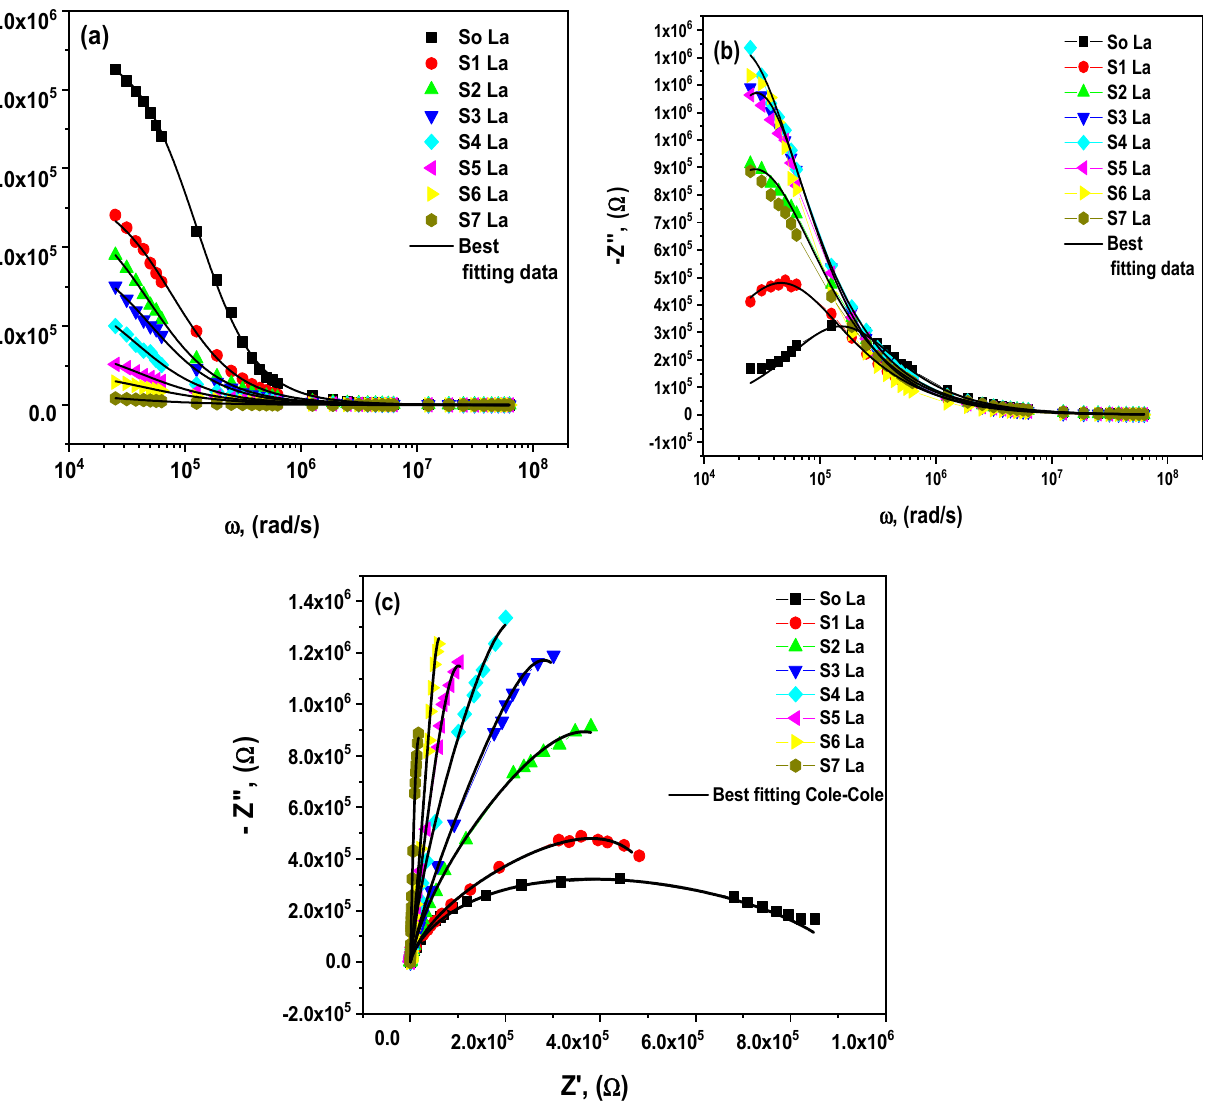
Figure 7. ( a – c ): ( a ) real, ( b ) imaginary parts, and ( c ) Cole-Cole plots (the line represents the theoretical best Cole-Cole fitting) as-prepared La 2 O 3 -ZnO nanostructures. The angular frequency dependence of −𝑍 (cid:4593)(cid:4593) (𝜔) is shown in Figure 7b. The experi- mental results from Figure 8b closely match the theoretical data from Equation (18). Each of the −𝑍 (cid:4593)(cid:4593) (𝜔) curves exhibit a beginning peek of the relaxation process, which changes its intensity because of lanthanum doping. This indicates a decrease in the loss of dopant nanoparticles, as reported by A. Azam et al. [55]. Figure 7c demonstrates the Cole–Cole diagrams to obtain the specimens’ dielectric parameters as a function of the various lan- thanum contents. Considering the studied corresponding circuit model nanomaterial for varistor applications is essential. This figure matches the fitting data and the practical results, indicating that the corresponding future circuit is appropriate for the material’s electrical properties. The obtained grain boundary of the circuit element value is displayed in Figure 8a. A comparable RC circuit was used to fit each semicircle, such as a parallel (cid:16) (cid:17) R gb grouping of bulk grain boundary resistance and bulk grain boundary capacitance ( CPE ) . The undoped ZnO material’s bulk resistance is larger than the bulk grain boundary resistance. Correspondingly, it was seen that the grain boundary resistance ( R gb ) declined due to lanthanum doping, where this concluded result agrees very well with the